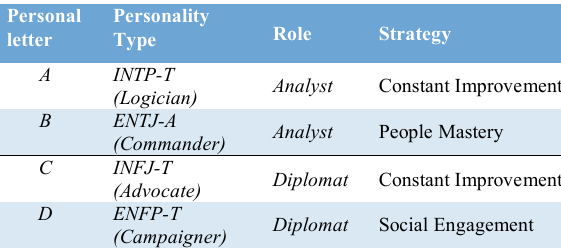
Tab. 1. Personality types obtained from the 16 personalities